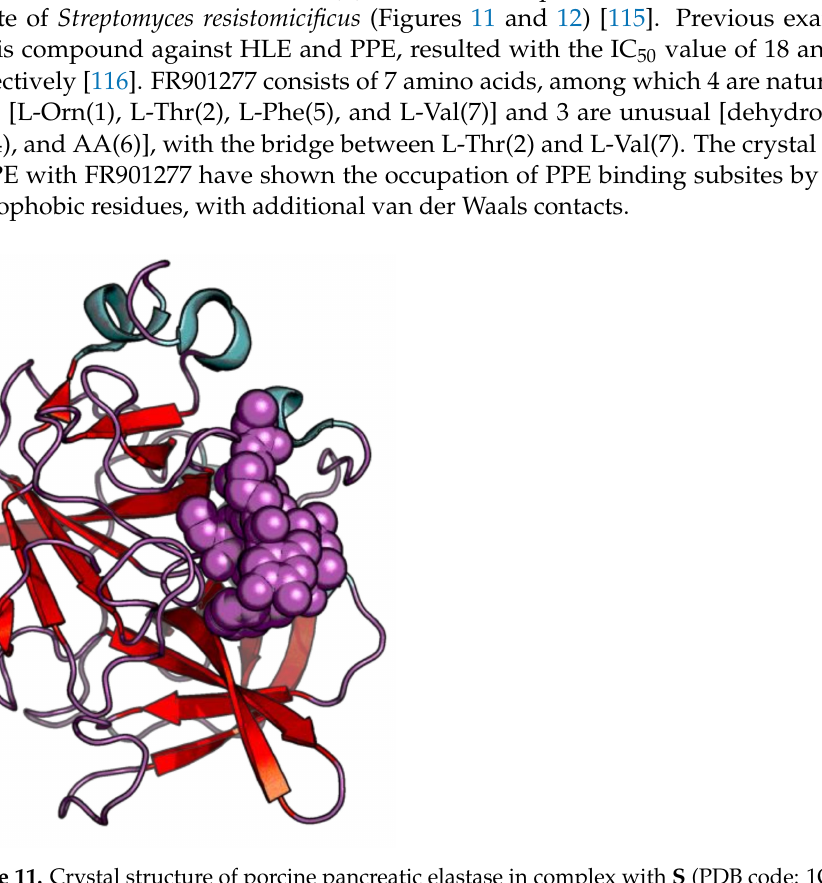
Figure 11. Crystal structure of porcine pancreatic elastase in complex with S (PDB code: 1QR3) [115]. The inhibitor molecule is presented as spheres.